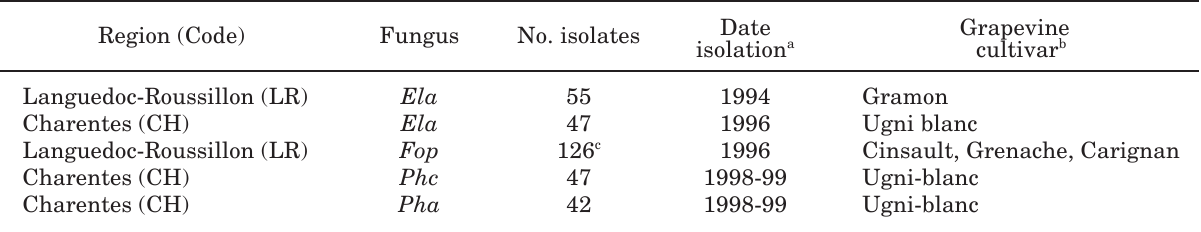
Table 2. Characteristics of populations of Eutypa lata ( Ela ) , Fomitiporia punctata ( Fop), Phaeoacremonium chlamy- dosporum ( Pch ) and P. aleophilum ( Pal ) collected at vineyard level.